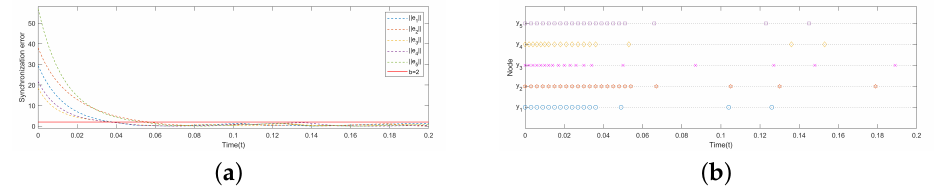
Figure 8. ( a ) RLS errors in the two − layered network. ( b ) Event − triggered instants on node y i under condition